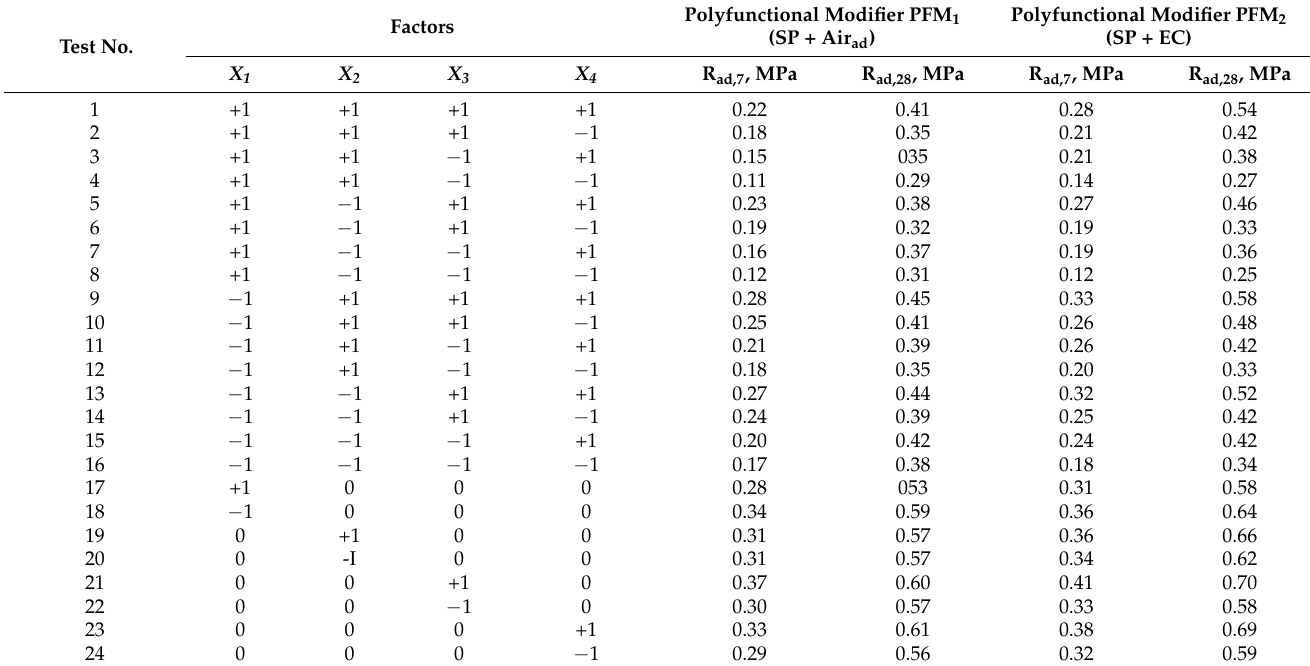
Table 5. Planning matrix and experimental adhesion-strength values.